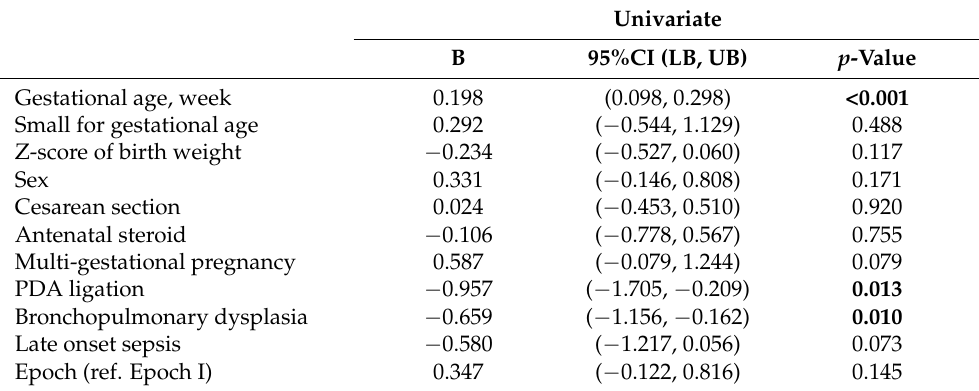
Table 2. Dependence of ∆ z-score of body weight at term equivalent age on clinical variables: univariate analysis.